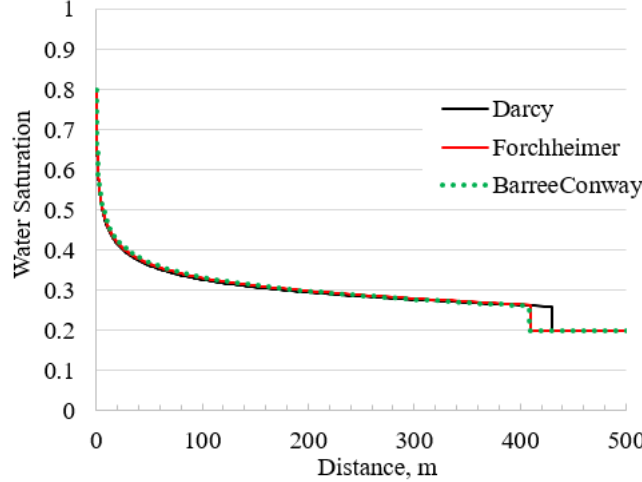
Figure 17. Displacement distance of waterfront travel.